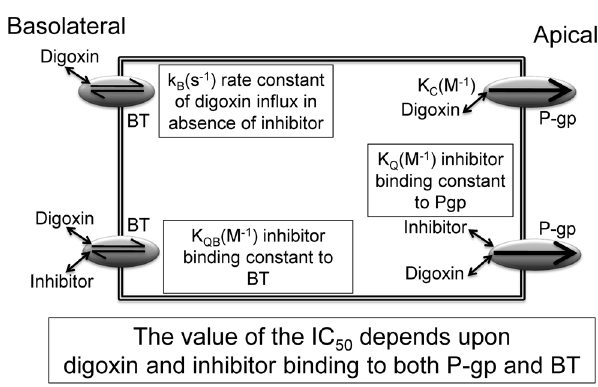
Figure 9. Model of transporters that are kinetically significant for digoxin transport and the inhibition of digoxin transport for all cell lines studied here. Starting from the basolateral chamber, the basolateral digoxin uptake transporter, denoted BT, transports digoxin into the cytosol more rapidly than bilayer permeability. This clearance is measured in the absence of inhibitor and denoted k B (s 2 1 ). Inhibitor binding to BT according to a binding constant denoted K QB (M 2 1 ), defined in Eq. 4 and shown in Table 3, can inhibit this digoxin transport. Efflux of digoxin from the cell into the apical compartment is mediated by P-gp, according to the digoxin kinetic parameters, Table 2. This efflux can be inhibited by competitive binding of the inhibitor to P- gp, according to its binding constant K Q , which is equal to K C in Table 2, since it is the inhibitor in this case.